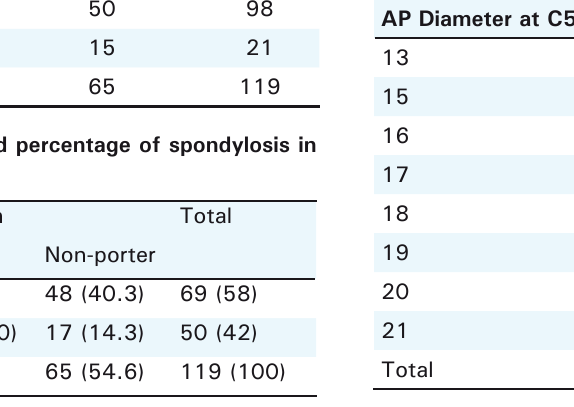
table 4. Spondylosis in porters and non-porters and calculation of chi square value and odds ratio Spondylosis